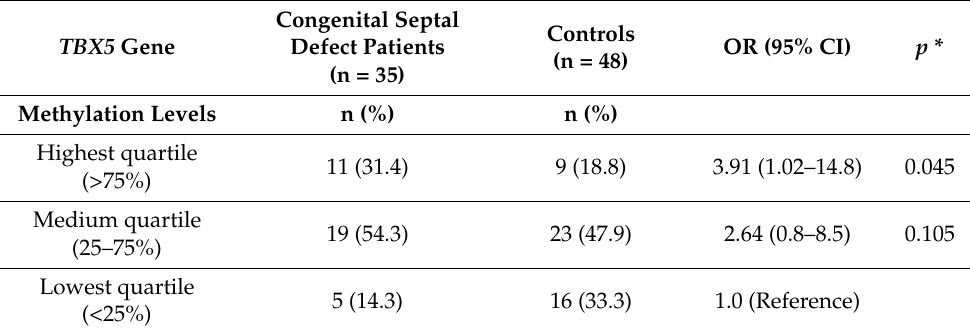
Table 2. Association between TBX5 methylation levels and risk of congenital heart defects. TBX5